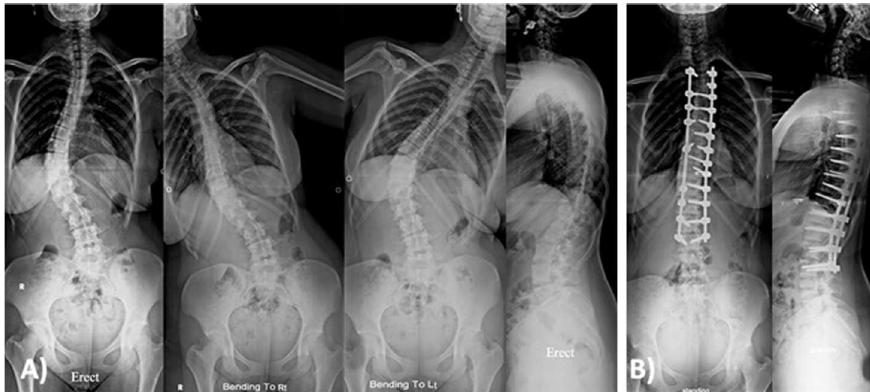
Figure 3. Female patient 18 years old with Lenke 1c n. (A) Preoperative X-rays showing main thoracic curve of 55 ° that was corrected to 15 ° in side bending films with thoracic kyphosis of 38 ° . (B) Two years postoperative X-rays showing posterior correction and fusion from T4-L3 with main thoracic curve correction to 5 ° with thoracic kyphosis of 26 ° .